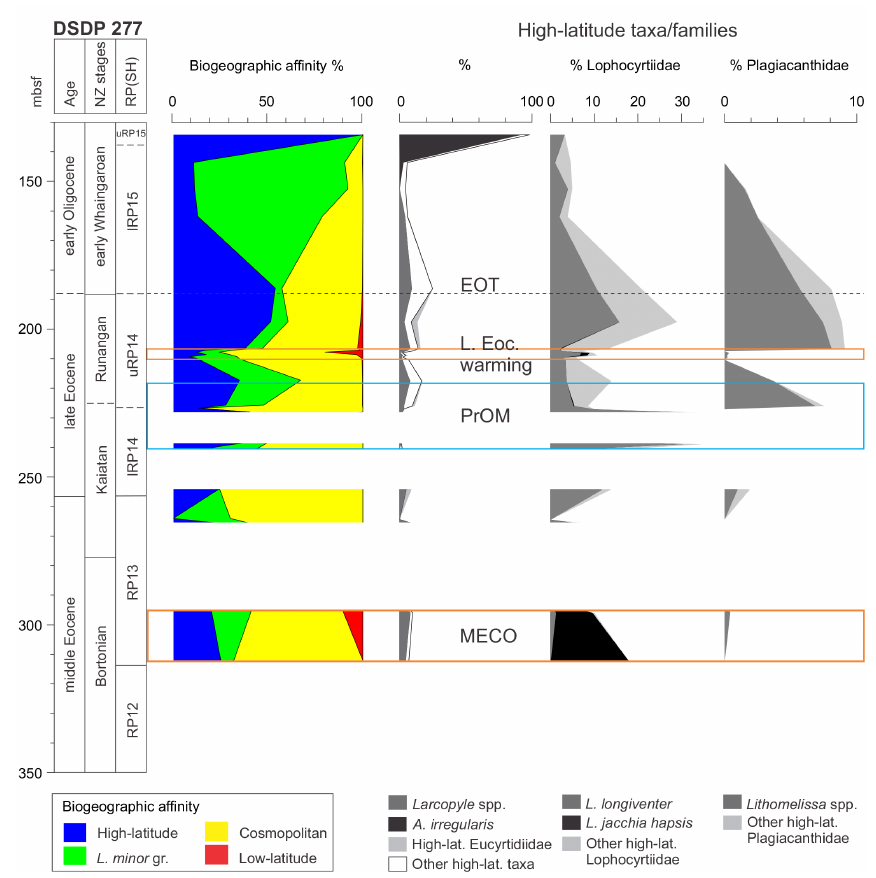
Figure 6. Biogeographic affinities of radiolarian assemblages at DSDP Site 277 and the abundance of high-latitude taxa/families. MECO: Middle Eocene Climatic Optimum; PrOM: Priabonian Oxygen Isotope Maximum; EOT: Eocene–Oligocene